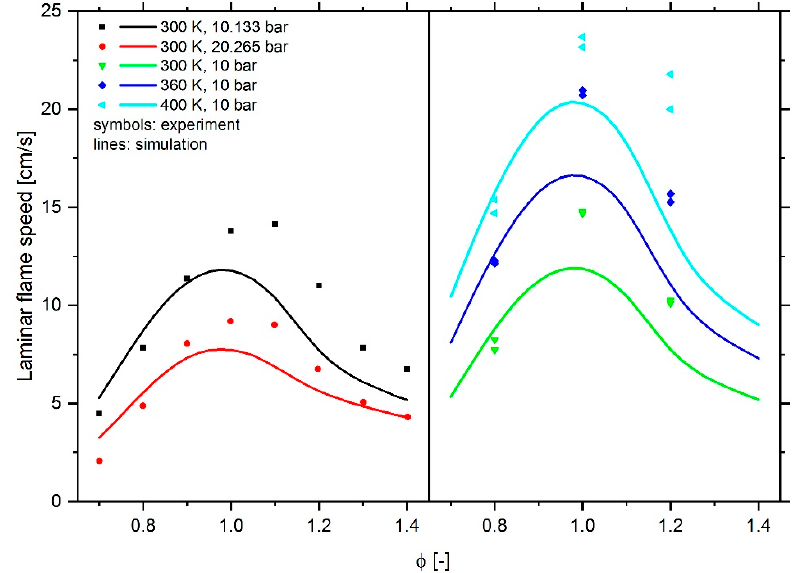
Figure 17. Measured laminar flame speeds (symbols) of methane–air mixtures [112] as function of the fuel–air equivalence ratio φ at different pressures and temperatures in comparison with simulated values (lines) using MechD.